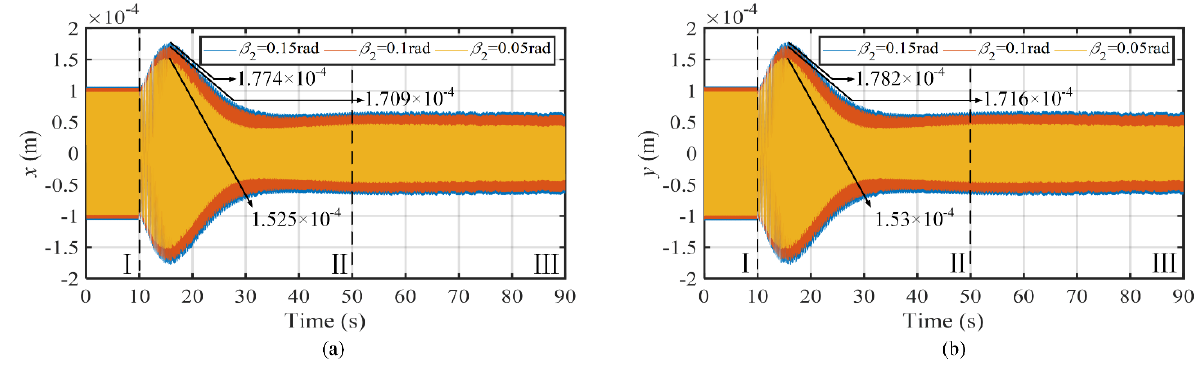
Figure 12. The time-domain figure of the hydro-turbine runner under different blade exit flow angles. ( a ) In x -direction; ( b ) in y -direction.